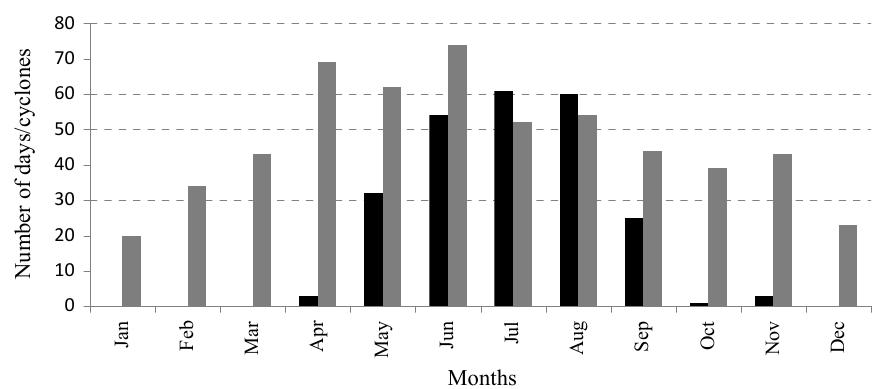
Fig. 4. Monthly numbers of thunder days associated with southern cyclones (black) having caused a thunder at least at one station and the number of southern cyclones (grey) in